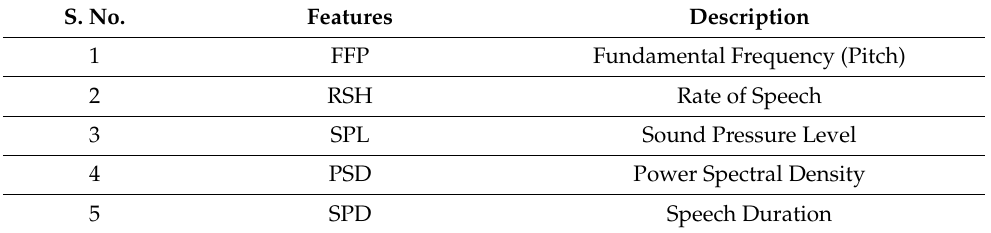
Table 4. List of vocal features.